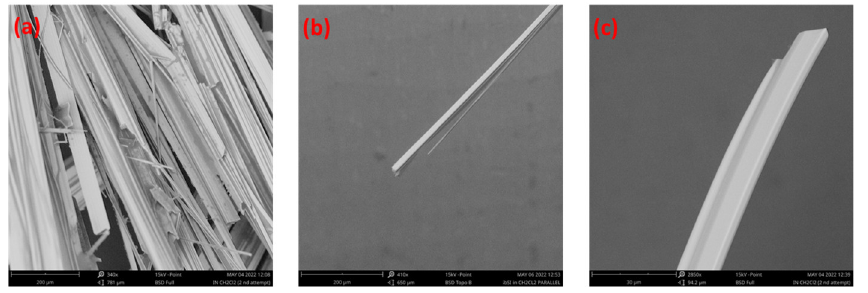
Figure 5. ( a ) SEM image of the branch of SbI 3 •3S 8 crystal. ( b ) and ( c ) SEM images of a single SbI 3 •3S 8 crystal after rotating the silicon wafer at a specific